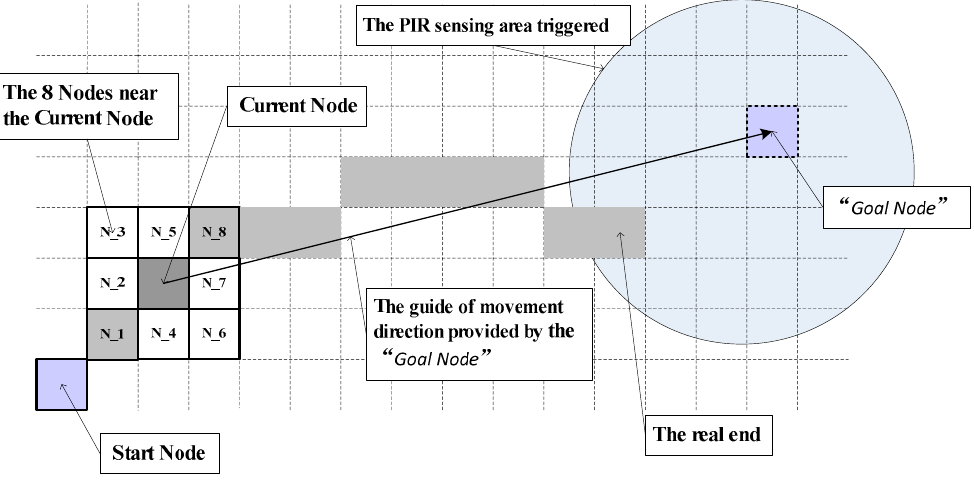
Figure 7. Diagram of target node estimation by the A-star algorithm.